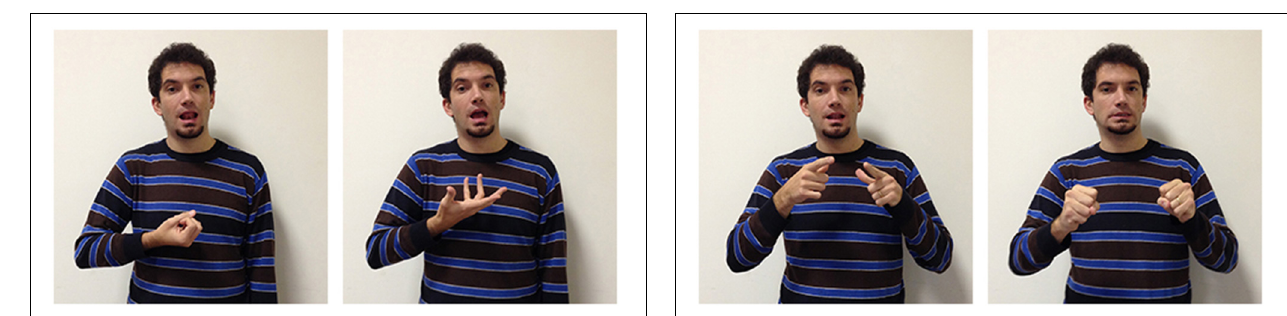
FIGURE 13 | LIS sign LANGUAGE / LINGUAGGIO .